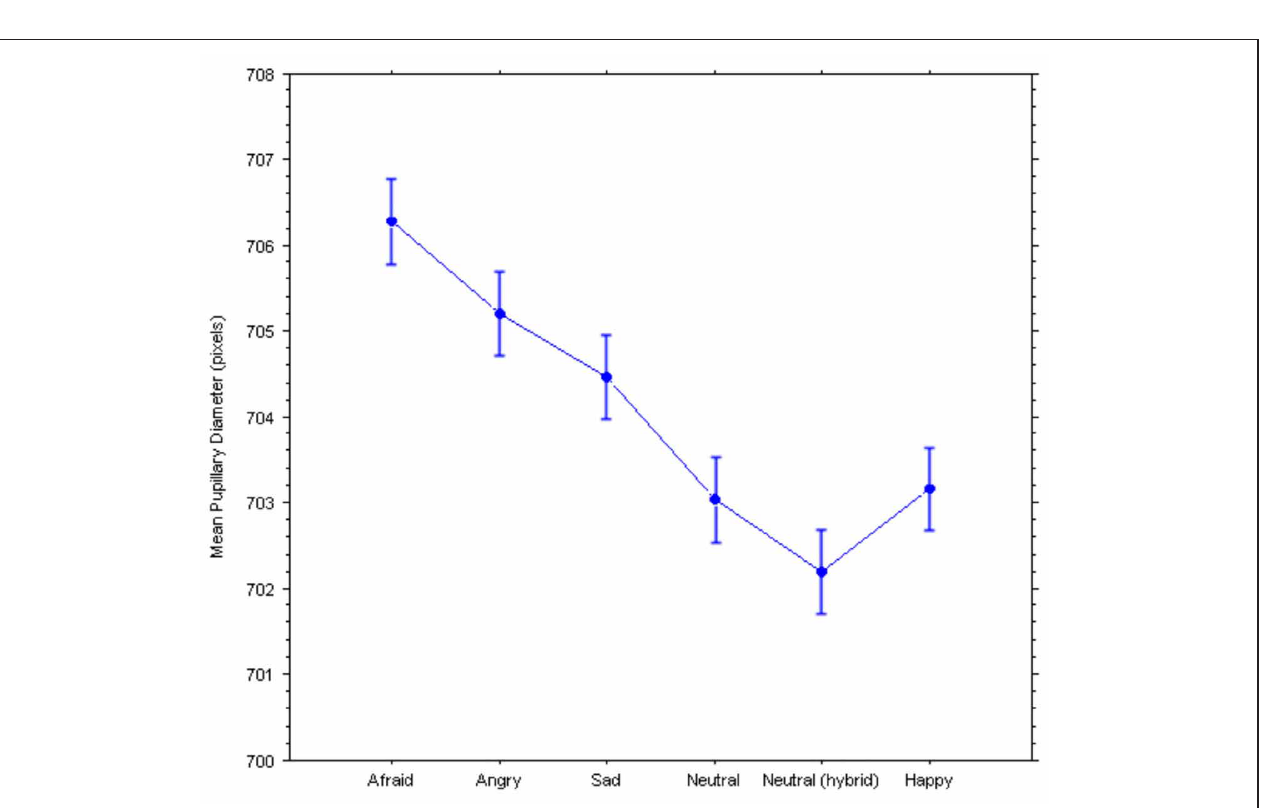
FIGURE 3 | Pupillary responses to the hybrid faces. Bars represent 95% confidence intervals for within-subject designs (Loftus and Masson, 1994).